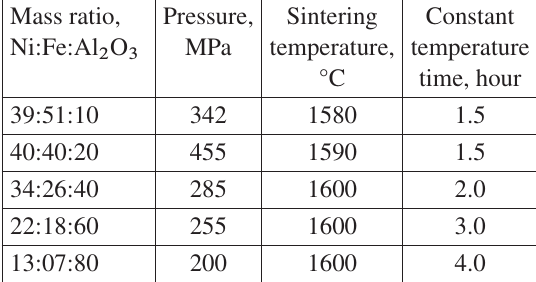
Table 1. Fe-Ni-Al 2 O 3 anodes processing conditions.